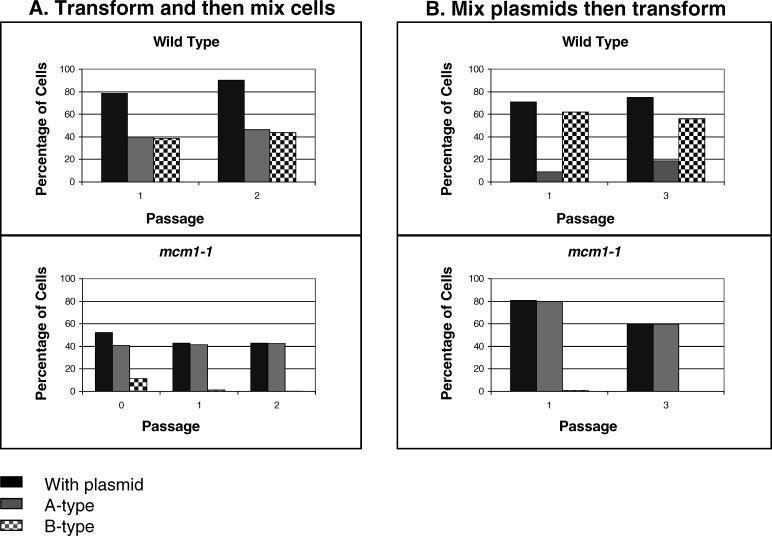
YCp121 Is More Stable than YCp1 in mcm1–1 CellsCells (wild-type or mutant) containing YCp121 or YCp1 were mixed (A). YCp121 and YCp1 were mixed and transformed into wild-type or mcm1–1 cells (B). Colonies on selective medium were pooled and used to inoculate a culture in selective media. The culture was grown to saturation (one passage) and used to inoculate a fresh culture of selective media. This process was repeated two or three times. The relative abundance of YCp1 containing ARS1 and YCp121 containing ARS121 was measured at the end of a passage.